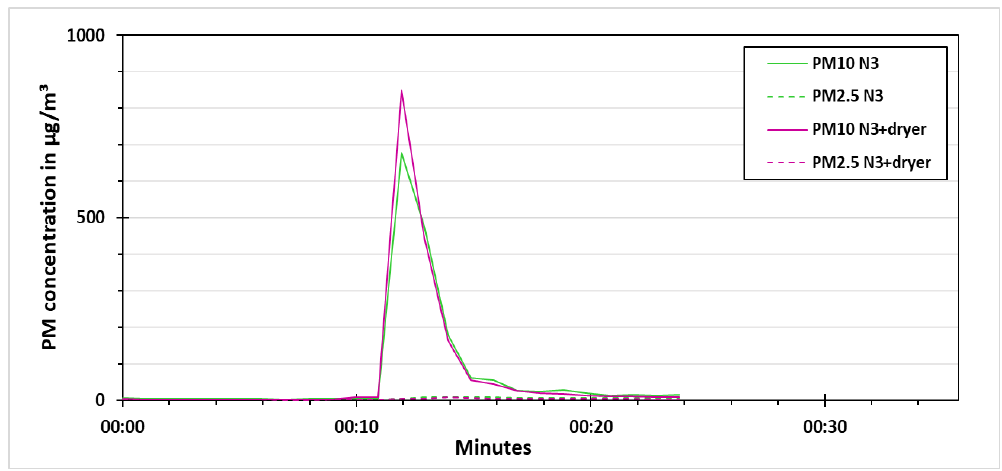
Figure 14. PM concentration for the synthetic dust experiment without vaporizer.